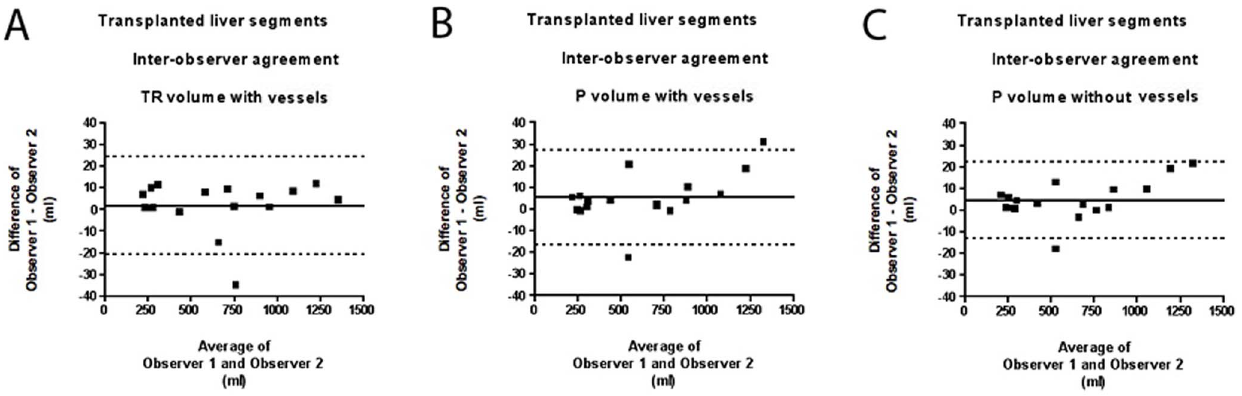
Figure 3. Blant-Altman Analysis for Inter-observer Agreement Regarding Volume of Transplanted Liver Segments. A Manual commercial software (TR) with vessels. B Semi-automated interactive software (P) with vessels. C Semi-automated interactive software (P) without vessels. Note: straight lines define bias; dotted lines define 95% limits of agreement; the inter-observer agreement can be regarded as ‘‘good’’ for the 3 different